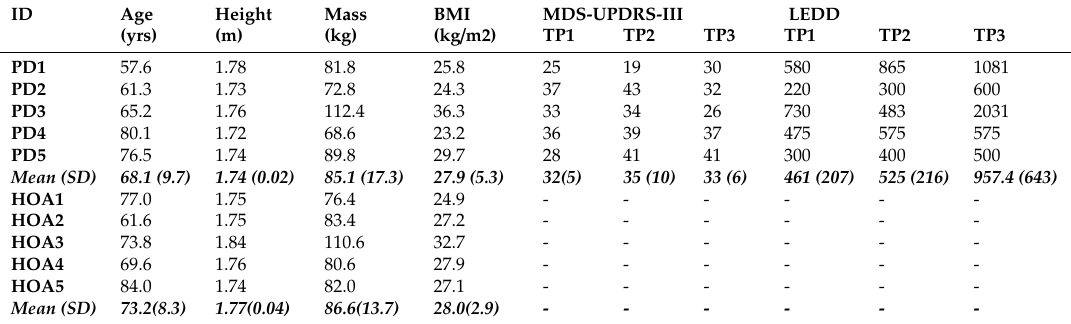
Table 1. Participant characteristics and clinical motor scores for a group with Parkinson’s disease.